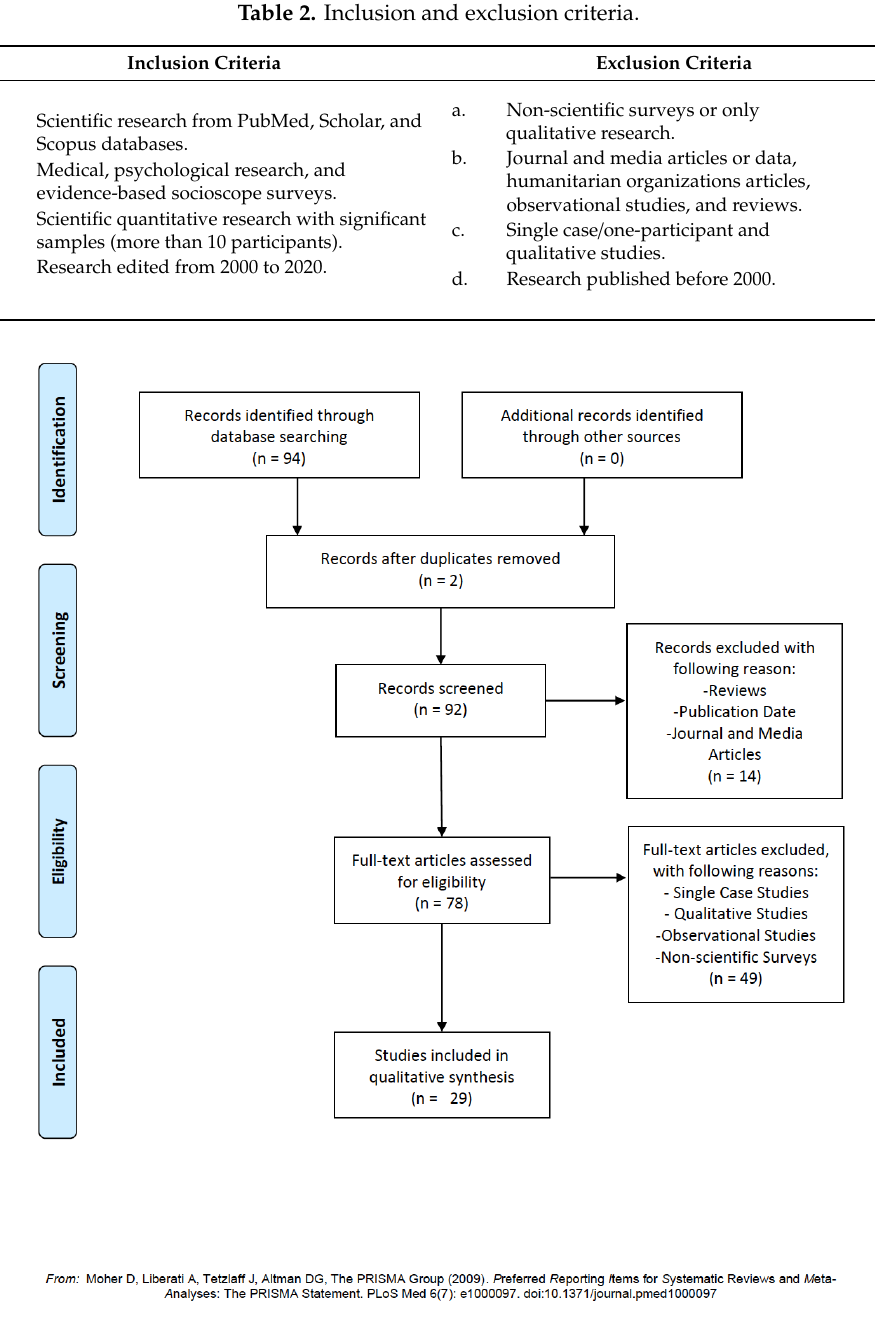
Figure 1. Preferred Reporting Items for Systematic Reviews and Meta-Analyses (PRISMA) flow-chart.